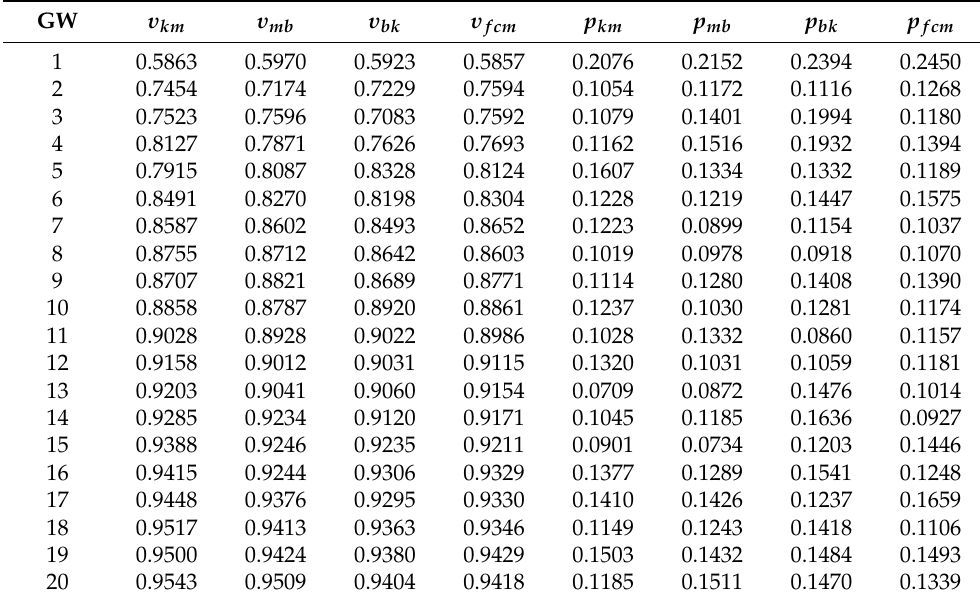
Table 4. ULDR and p -values obtained from the application of each clustering method for the different number of GWs (Scenario 2).